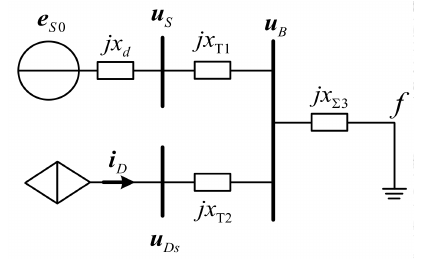
Figure 2. Equivalent circuit of double-machine